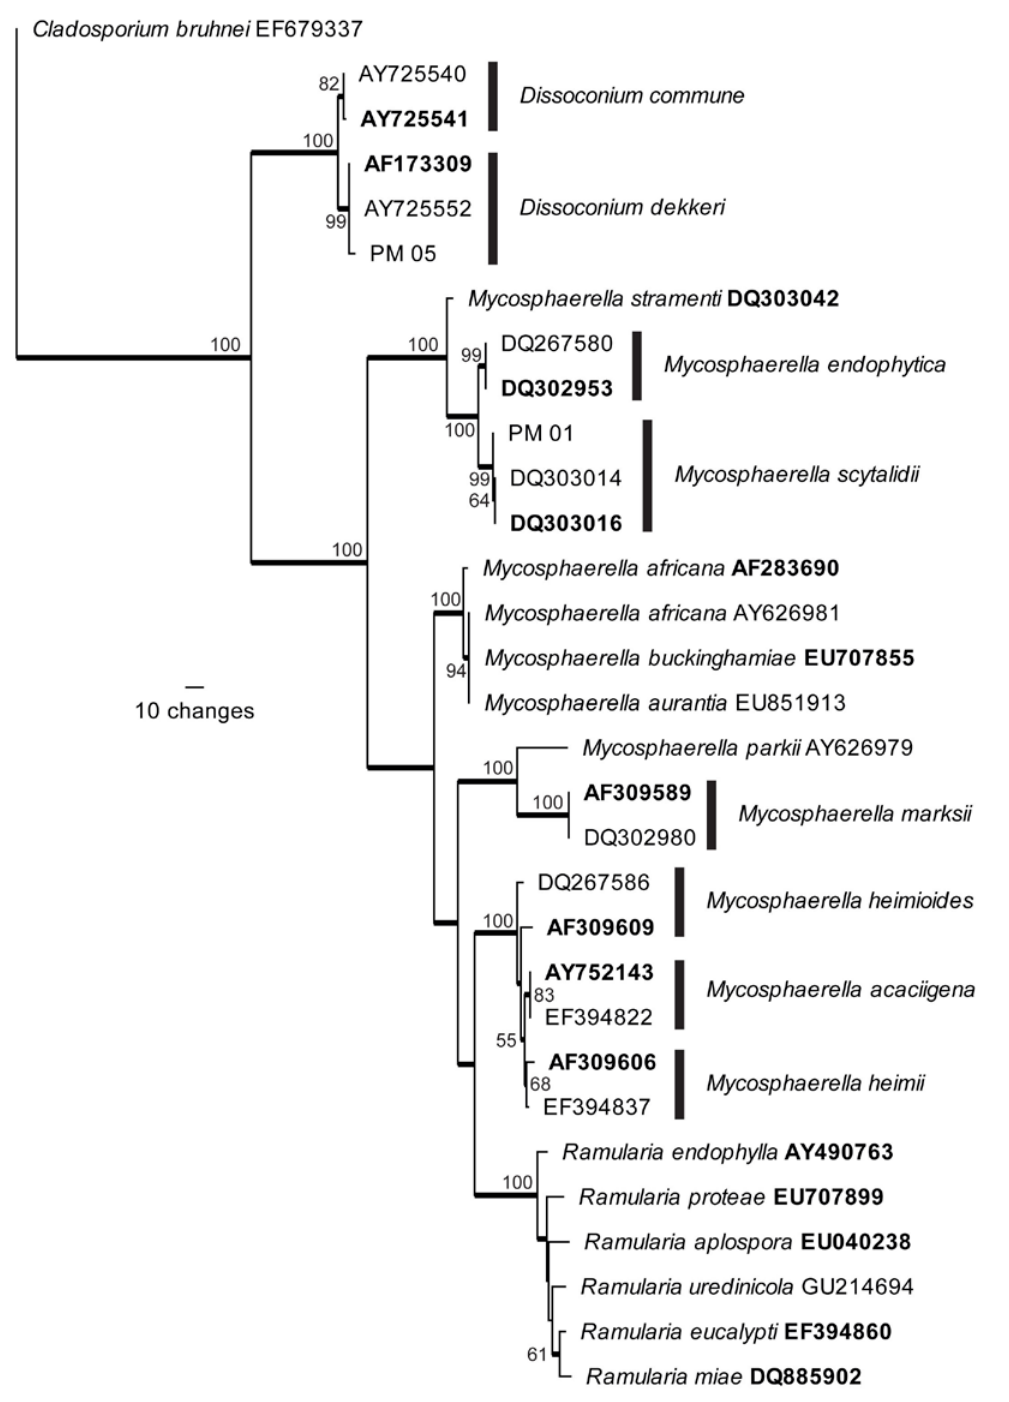
Figure 1. The first of three equally most parsimonious trees obtained from a heuristic search with 100 random taxon addi - tions of the Mycosphaerella / Dissoconium ITS sequence alignment. The scale bar shows ten changes, and bootstrap support values from 1000 replicates are shown at the nodes. The sequences from ex-type strains are shown in bold face and branch - es present in the strict consensus tree are thickened. The tree was rooted to Cladosporium bruhnei (GenBank